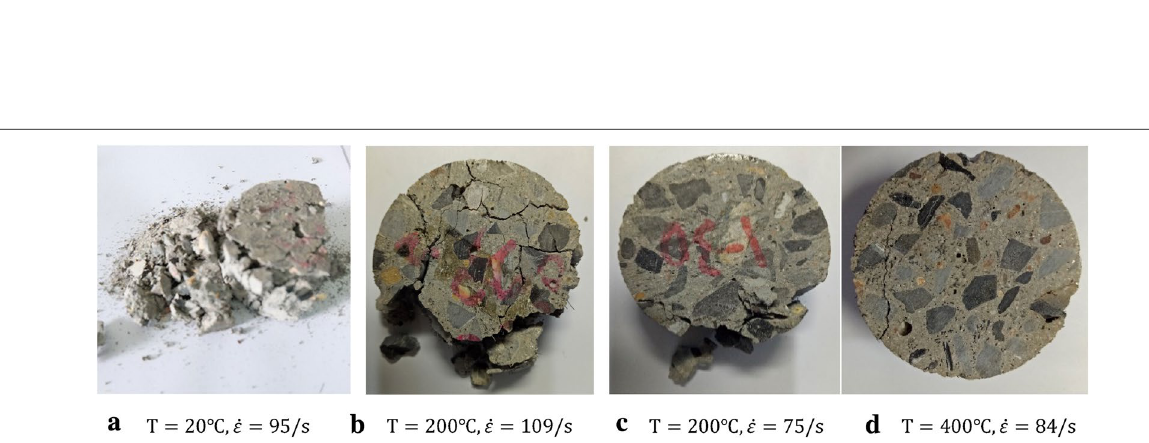
Fig. 13 Failure modes of SFRC with fiber volume fraction of 1.5% at different